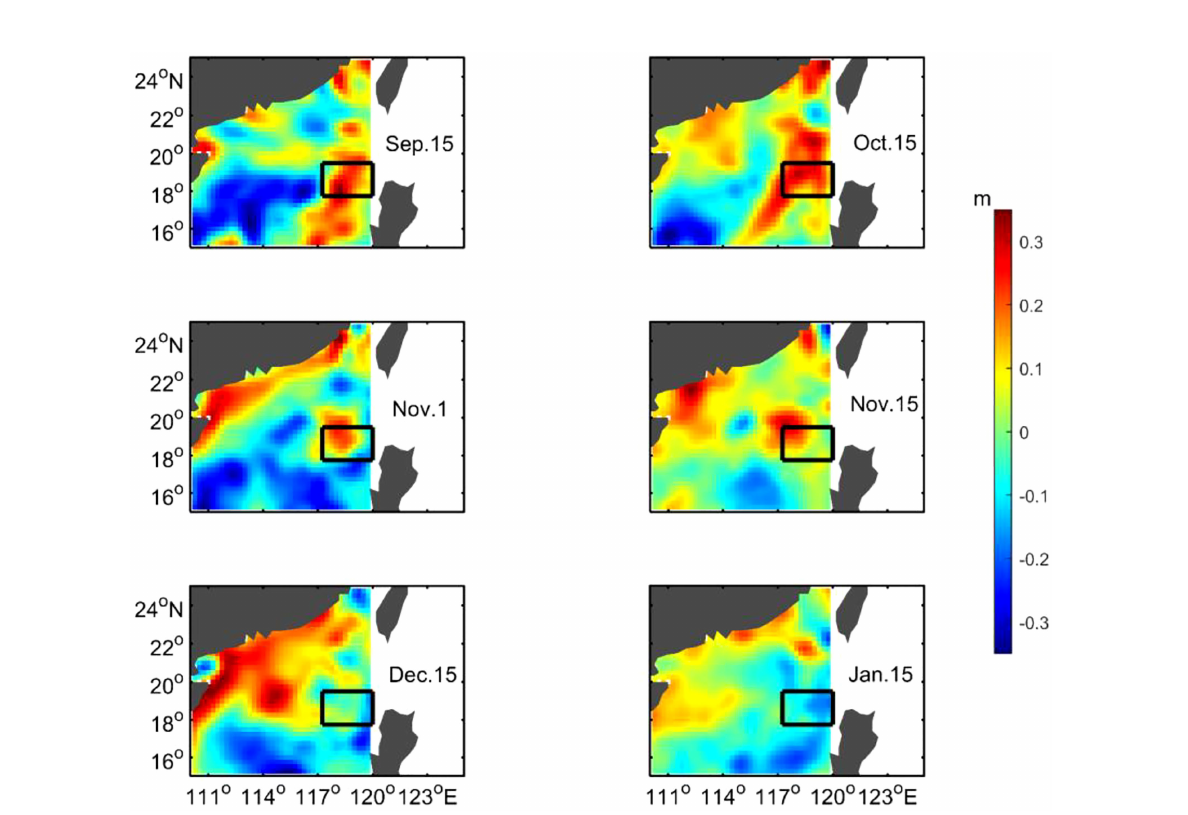
FIGURE 14 SLA (colours) from 15 September 2006 through 15 January 2007 in the western Luzon Strait. Black squares denote the locations of observed pro fi les from WOD18.